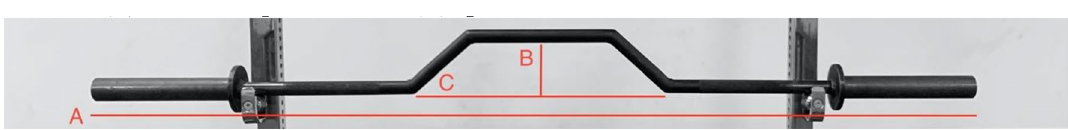
Figure 2. The cambered barbell characteristics as previously presented elsewhere 6 . Weight—20 kg; ( A ) overall length—190 cm; ( B ) camber depth—10 cm; ( C ) space between camber—55